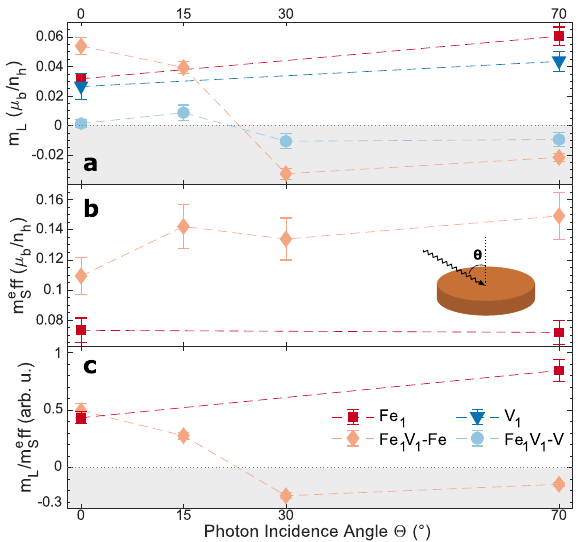
Figure 2. Orbital magnetic moments ( a ), effective spin magnetic moments ( b ) and ratio thereof ( c ) obtained via the sum rules 20,21 for the investigated adsorbate systems as a function of photon incidence angle θ . As the V L 2,3 -edges are not separated well enough, only the orbital moments are calculated for those edges. The inset in ( b ) serves as a reminder of θ used in this